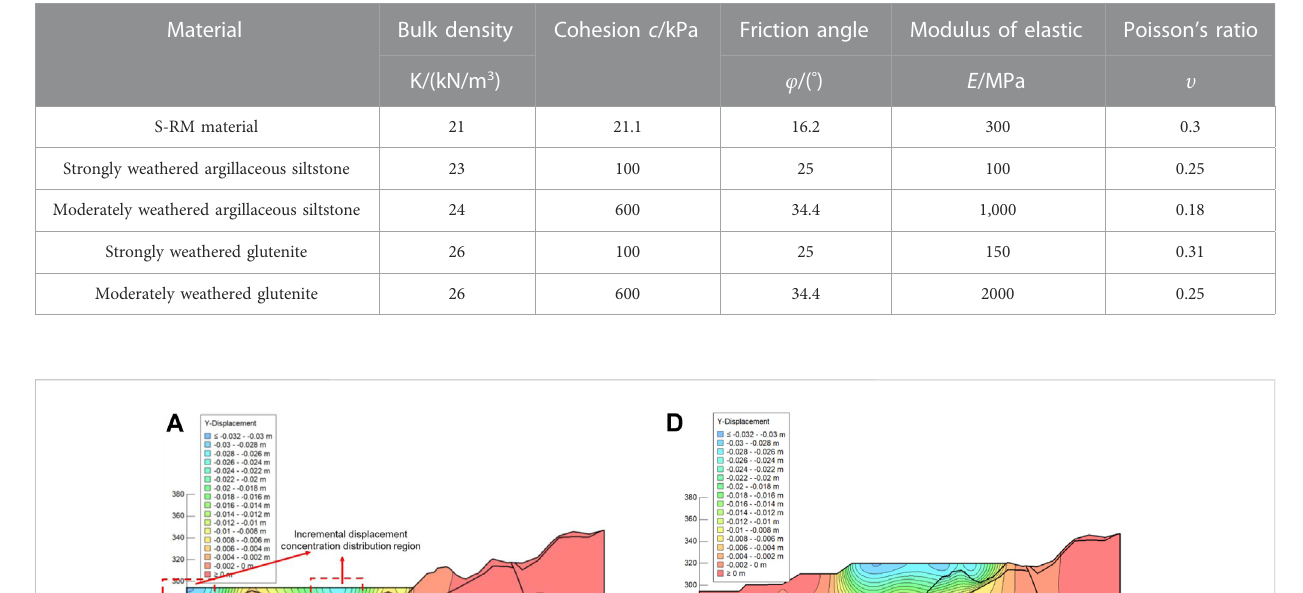
TABLE 1 Material parameters.